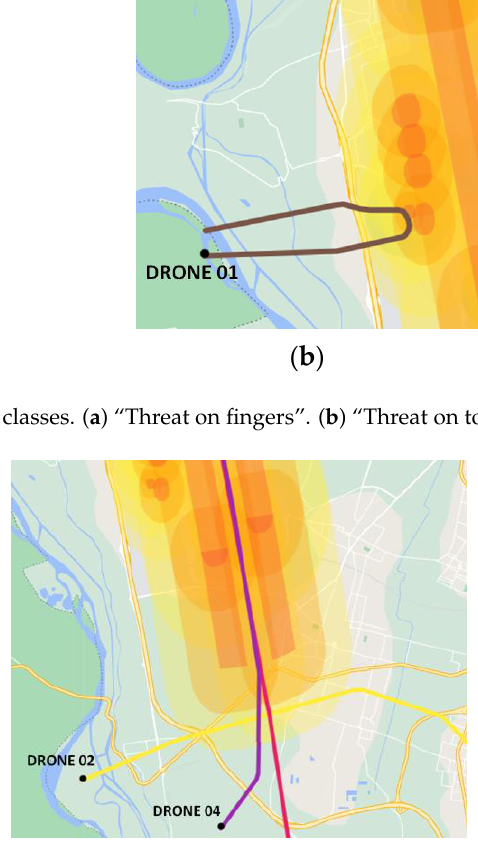
Figure 18. Instances of threat scenario classes. ( a ) “Threat on routes (SIDs)”. ( b ) “Threat on routes (STARs)”.